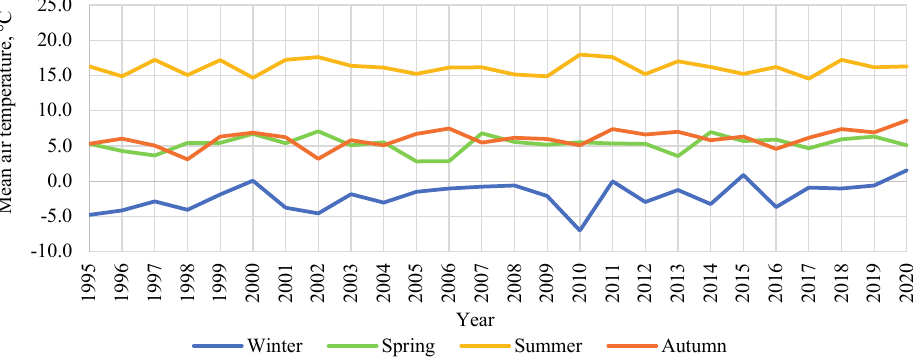
Fig. 5. Mean seasonal air temperature (°C) in the Vienziemite monitoring site, time period 1995–2020. In the Vienziemite monitoring site mean air temperature in winter was –2.1°C, 5.3 °C